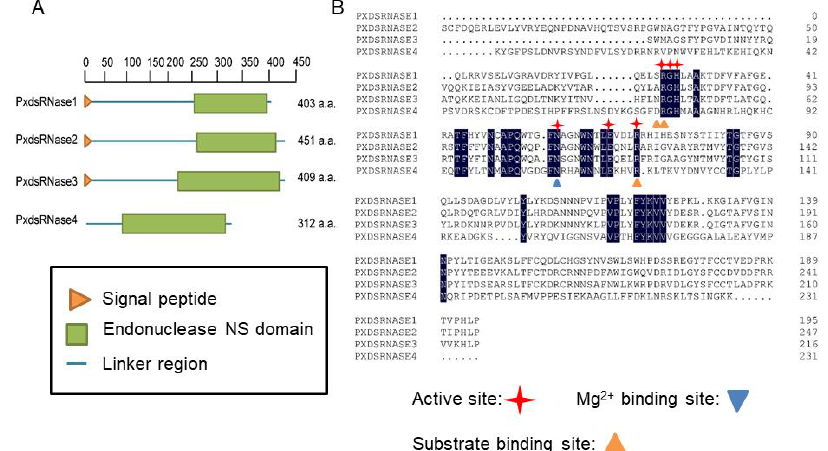
Figure 1. Analysis of deduced amino acid sequences of PxdsRNase genes. ( A ) Schematic diagram of deduced amino acid domains of PxdsRNase1, PxdsRNase2, PxdsRNase3 and PxdsRNase4. An orange triangle stands for the location of signal peptide, green boxes endonuclease NS domains, and blue lines linker regions. ( B ) Multiple sequence alignments of endonuclease NS domain of deduced dsRNase amino acid sequences in P. xylostella .